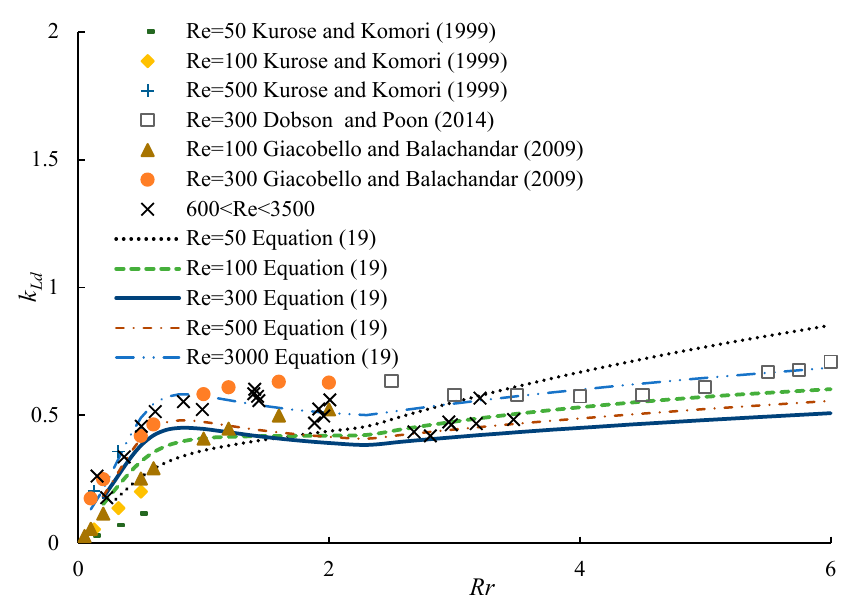
Figure 10. The distribution of the lift-to-drag ratio against the Reynolds number [13,33,34].